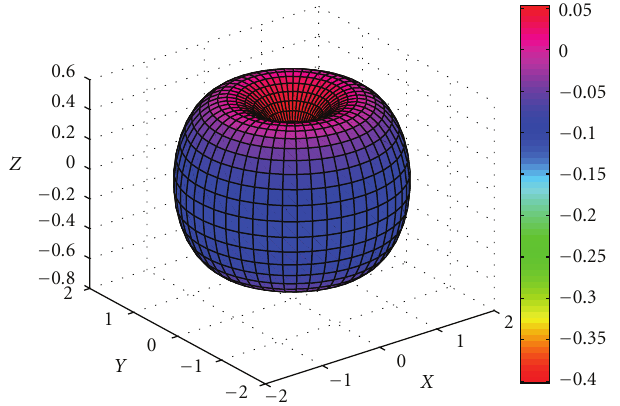
Figure 3: Gain patterns of half-wavelength dipole antenna with inclination angle of 0: G ( v ) ( θ , φ ). The horizontal component G ( h ) ( θ , φ ) is zero.